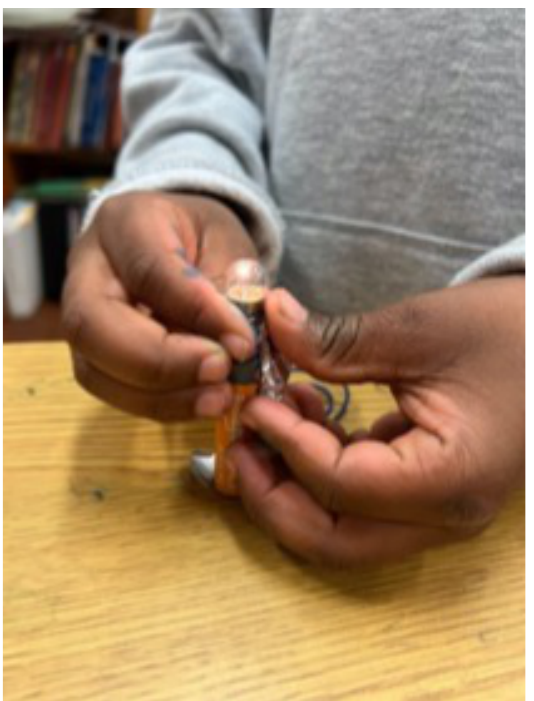
Figure 2 . A Student Using his Knowledge of Circuits and Conductors to Turn on a